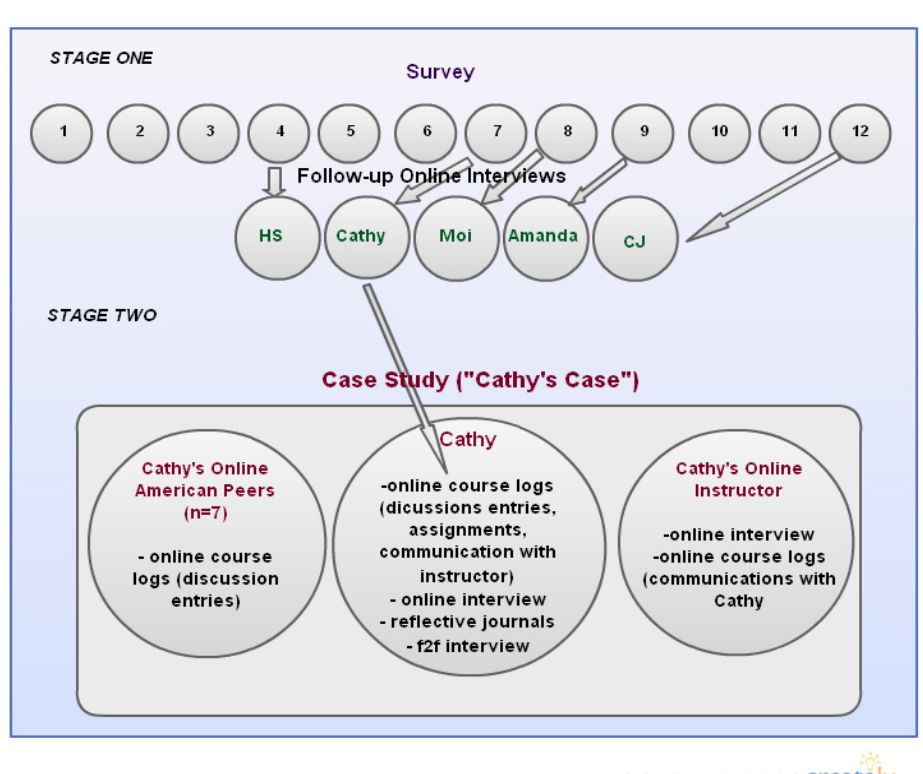
Figure 1 . Research